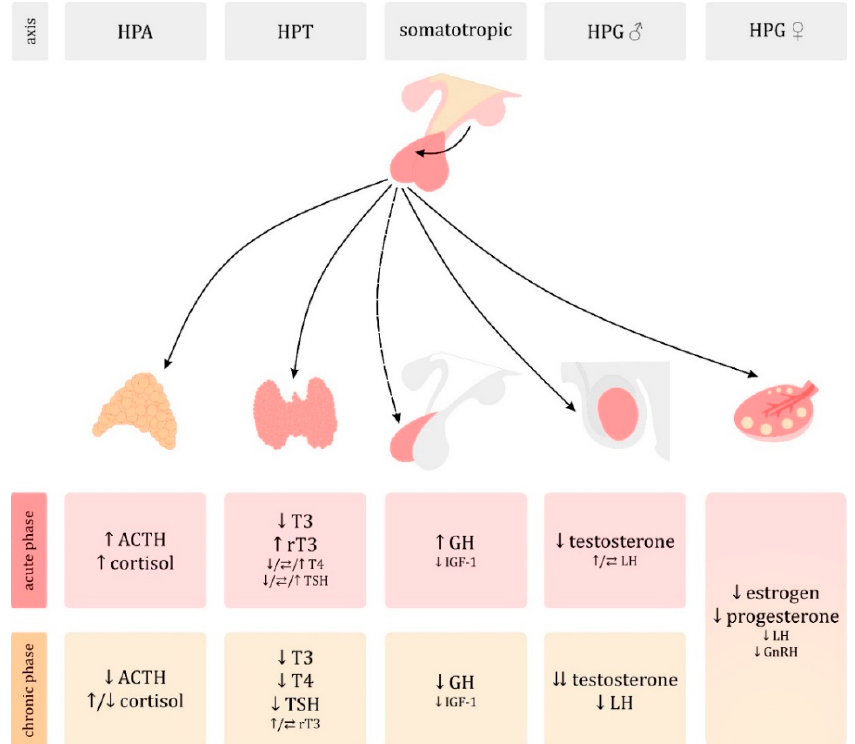
Figure 2. Hormonal changes in sepsis—differences between acute and chronic phases. Symbols: ↑ − increase; ↓ − decrease, (cid:28) − normal, − male, − female. Abbreviations: ACTH, adrenocorticotropic hormone (corticotropin); GH, growth hormone (somatropin); GnRH, gonadotropin-releasing hormone (gonado-liberin); HPA, hypothalamic-pituitary-adrenal; HPG, hypothalamic–pituitary–gonadal; HPT, hypothalamic–pituitary–thyroid; IGF-1, insulin-like growth factor I; LH, luteinizing hormone; rT3, reverse triiodothyronine; T3, triiodothyronine; T4, thyroxine; TSH,